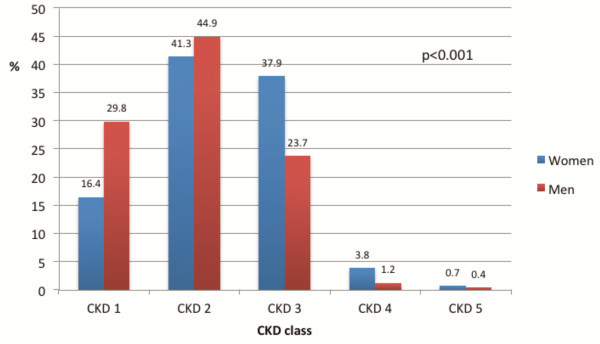
Chronic Kidney Disease (CKD) stage at admission according to gender. CKD 1: Chronic Kidney disease stage 1: eGFR ≥ 90 mL/min/1.73 m2. CKD 2: Chronic Kidney disease stage 2: eGFR ≥ 60 - < 90 mL/min/1.73 m2. CKD 3: Chronic Kidney disease stage 3: eGFR ≥ 30 - < 60 mL/min/1.73 m2. CKD 4: Chronic Kidney disease stage 4: eGFR ≥ 15 - < 30 mL/min/1.73 m2. CKD 5: Chronic Kidney disease stage 5: eGFR < 15 mL/min/1.73 m2. Blue bars = women. Red bars = men.